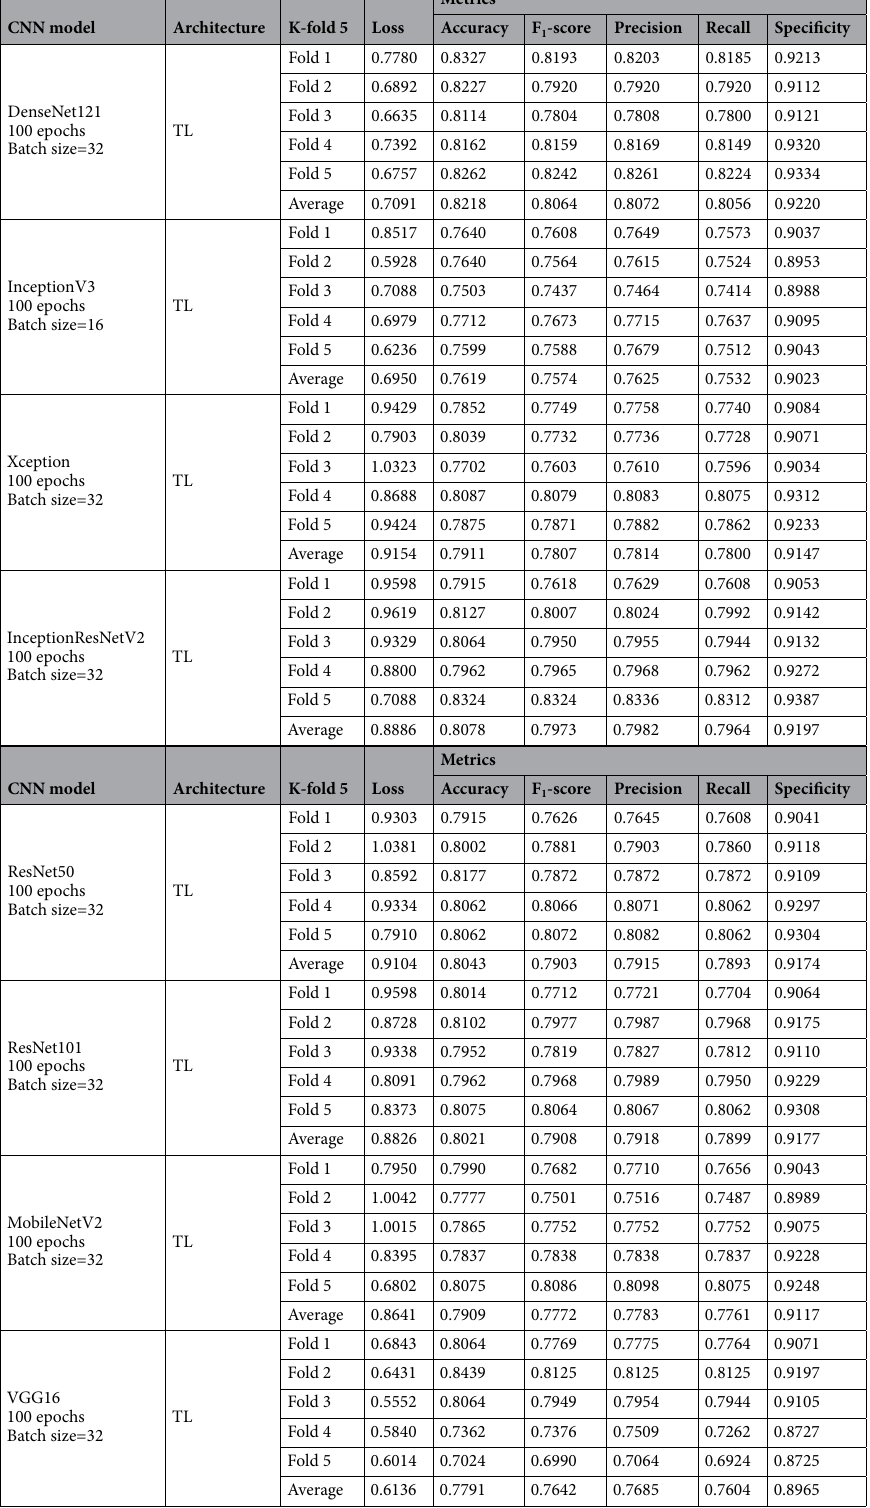
Table 1. Summarized results of the metrics of the seven models evaluated in a pilot test to support the decision-making process for the selection of a network. CNN convolutional neural network using transfer- learning